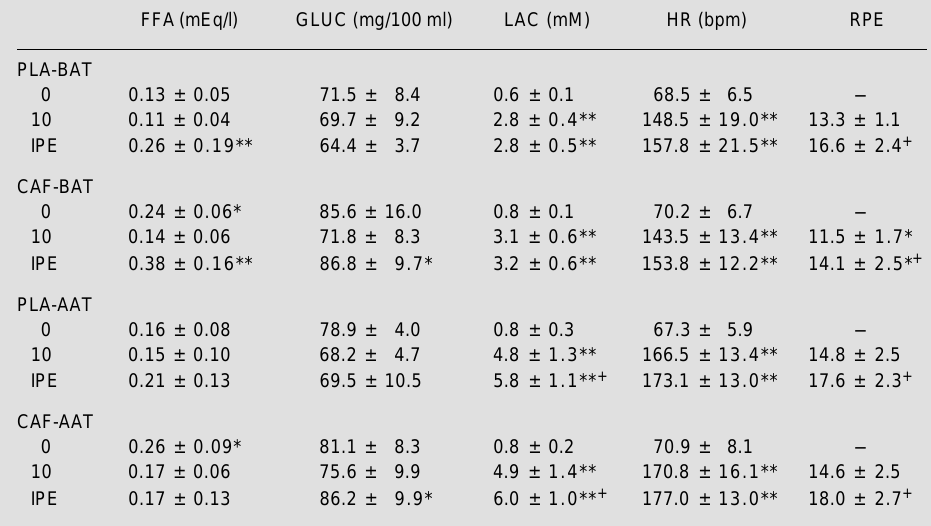
Table 2 - Effect of caffeine on free fatty acids, glucose, lactate, heart rate, and rate of perceived exertion at rest and during exercise. Data are reported as means ± SD for free fatty acids (FFA), glucose (GLUC), lactate (LAC), heart rate (HR) and rate of perceived exertion (RPE) immediately before exercise (0), at 10 min of exercise (10), and immediately after exercise (IPE) under the experimental conditions involving caffeine (CAF; 5 mg/kg) and placebo (PLA), during exercise below (BAT) and above (AAT) the anaerobic threshold. *P<0.05 compared to PLA at the same time and intensity of exercise. **P<0.05 compared to 0 min in the same condition. + P<0.05 compared to 10 min in the same condition (N = 8) (two-way ANOVA + Tukey